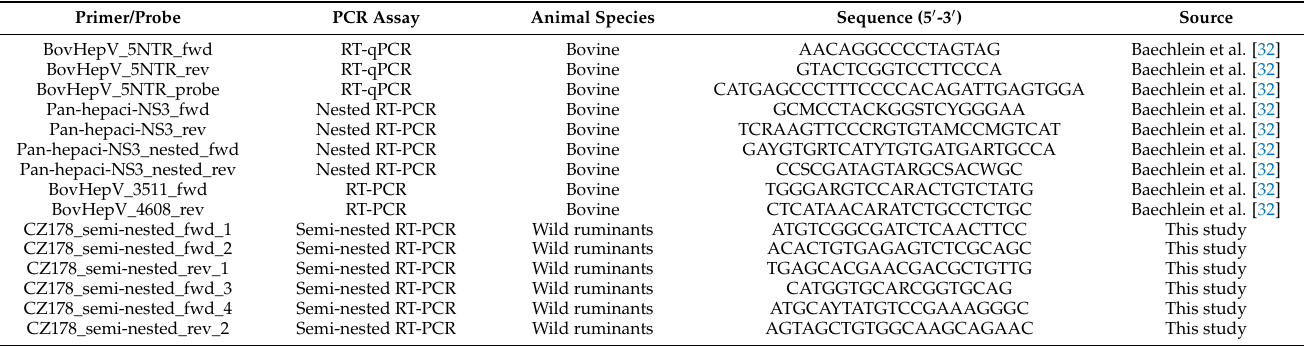
Table 1. Overview of primers used in this study to detect and characterize BovHepV RNA.